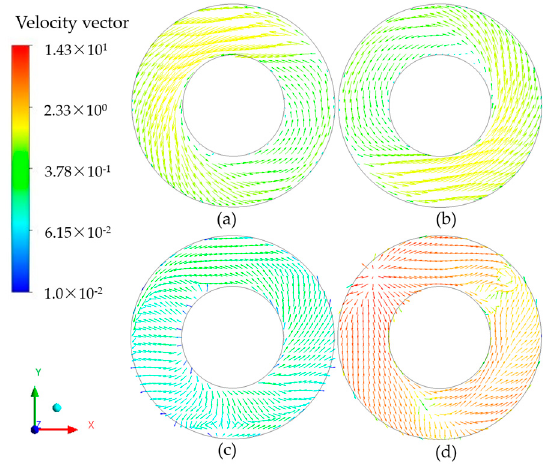
Figure 8. Velocity field distributions in the cross section of 7075 alloy melt in the stirring crucible by AEMS and M-AEMS: ( a ) velocity field distribution on the melt top surface of AEMS; ( b ) velocity field distribution on the melt bottom of AEMS; ( c ) velocity field distribution on the melt top surface of M-AEMS; ( d ) velocity field distribution on the melt bottom of M-AEMS.